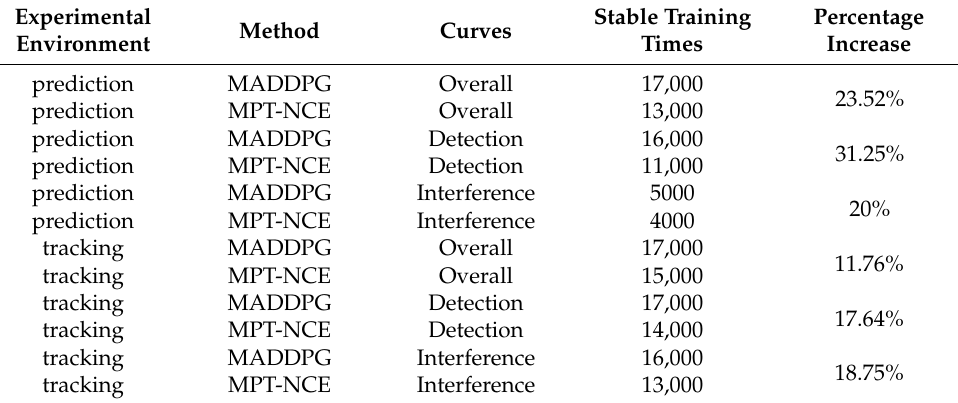
Table 5. Comparison of stable training times under different experimental